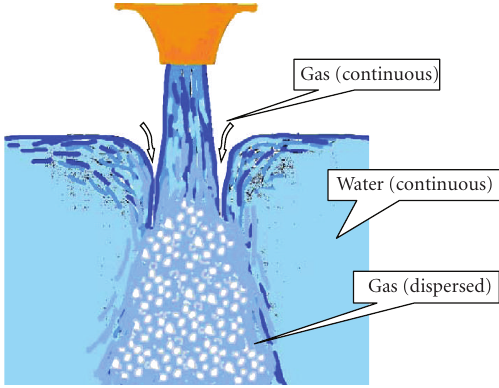
Figure 1: Morphologies of the phases near an impinging jet.